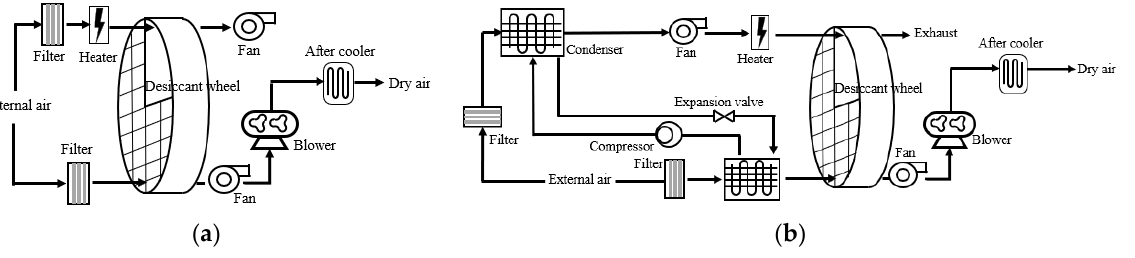
Figure 7. Desiccant wheel dehumidification system (DWDS) and HDS without a separated heat pipe . ( a ) DWDS. ( b ) HDS without a separated heat pipe.